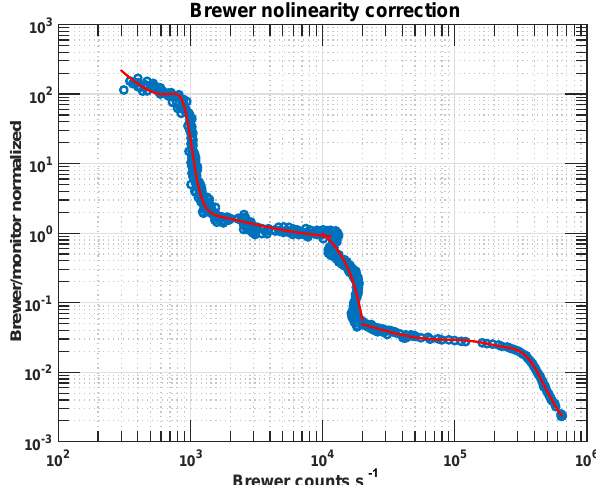
Figure 4. Log–log plot of the normalized ratio of measured Brewer counts to the monitor photodiode signal, which is proportional to the laser power, plotted as a function of the Brewer countss − 1 . The black points shows the measured points while the red curve is the fit used to correct the Brewer signals for the